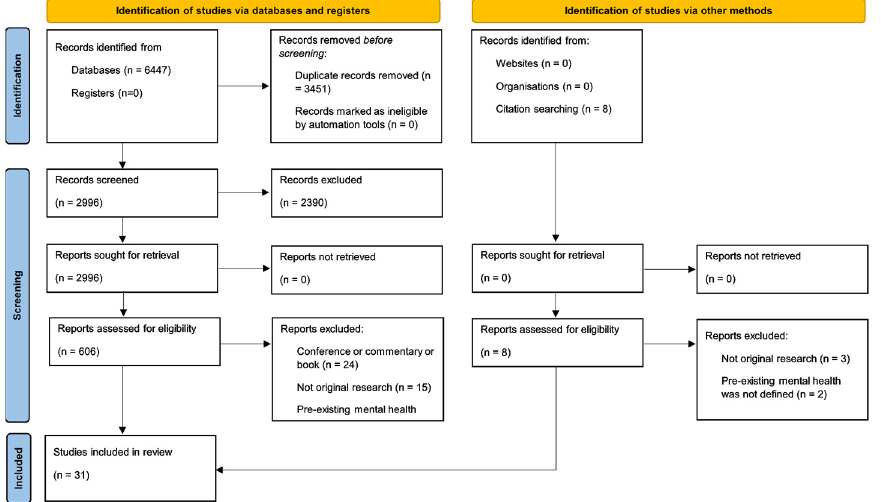
Figure 1. PRISMA 2020 flow diagram of studies included in the review to investigate the mental health impacts of climate-driven events among people with pre-existing mental health problems [28].